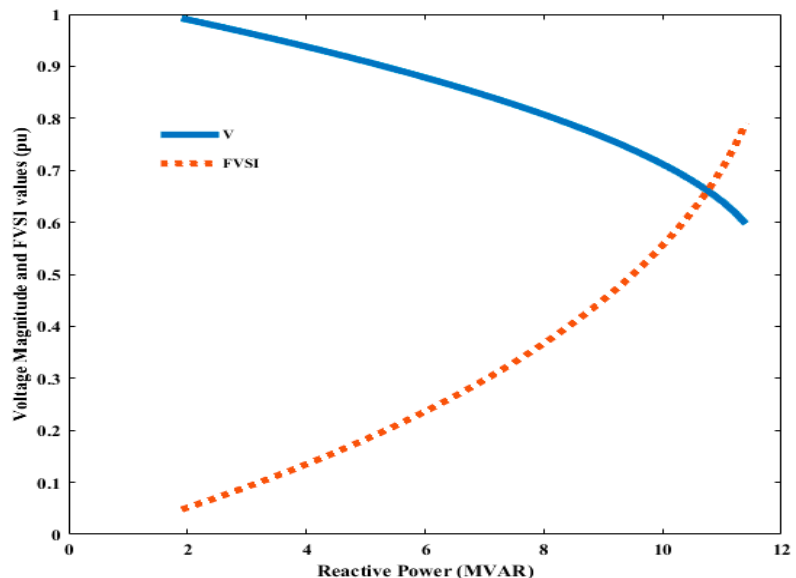
Figure 5. The trend of voltage magnitude and FVSI values with increasing reactive power. MVARs: reactive power mega volts amperes.